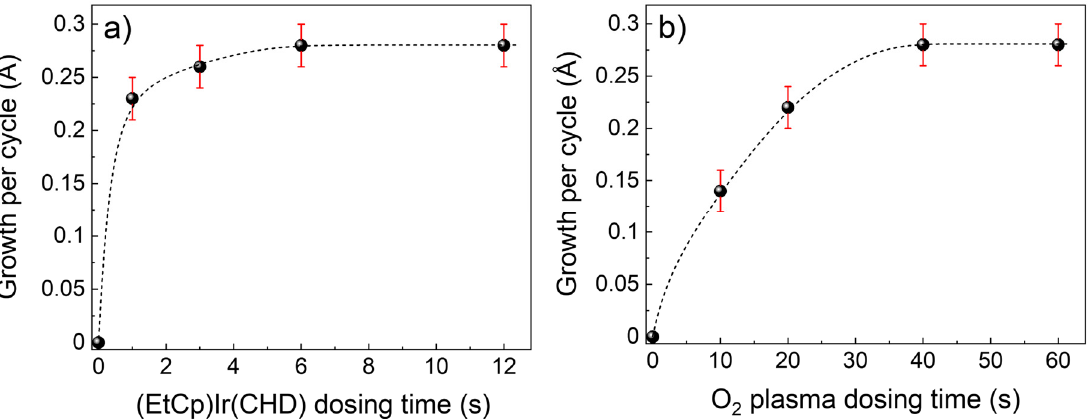
Figure 2. Saturation curves for ALD of IrO 2 . ( a ) GPC as function of the (EtCp)Ir(CHD) dosing time. ( b ) GPC as function of the O 2 plasma dosing time. Dashed lines are a guide to the eyes.